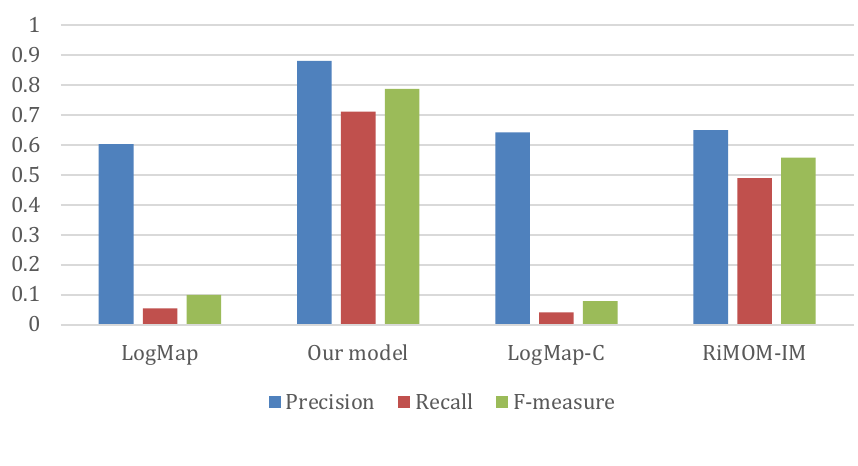
Figure 3. OAEI 2014 comparison